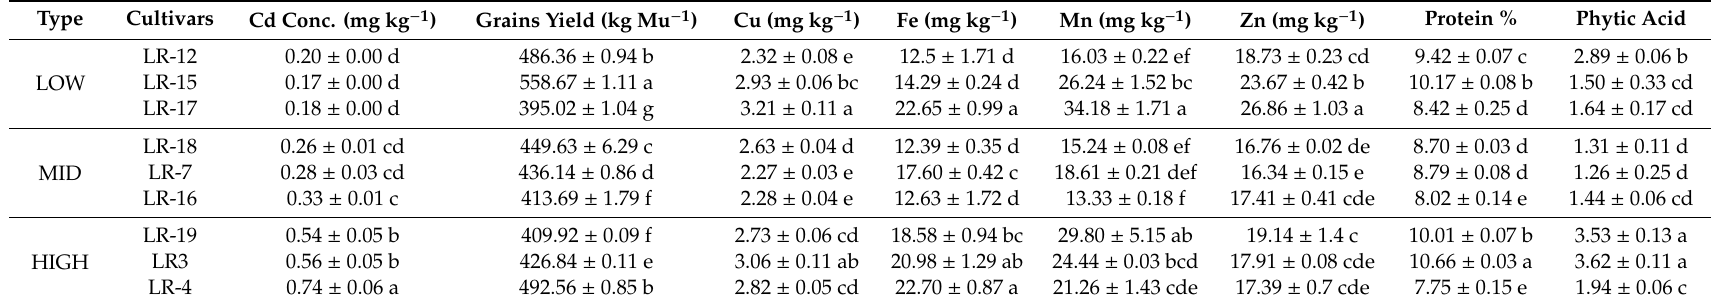
Table 2. Grain Cd concentration, grain yield and mineral nutrient concentration in polished rice of cultivars in the 2nd year experiment. Data are means of three replicates; followed by di ff erent letters indicate significant di ff erence p < 0.05. MID and HIGH represent medium and high Cd accumulation cultivars in the first-year